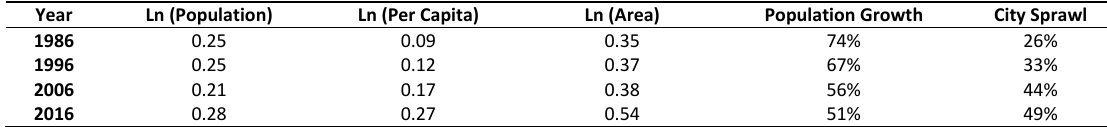
Table 8: The calculations of Holdren entropy model